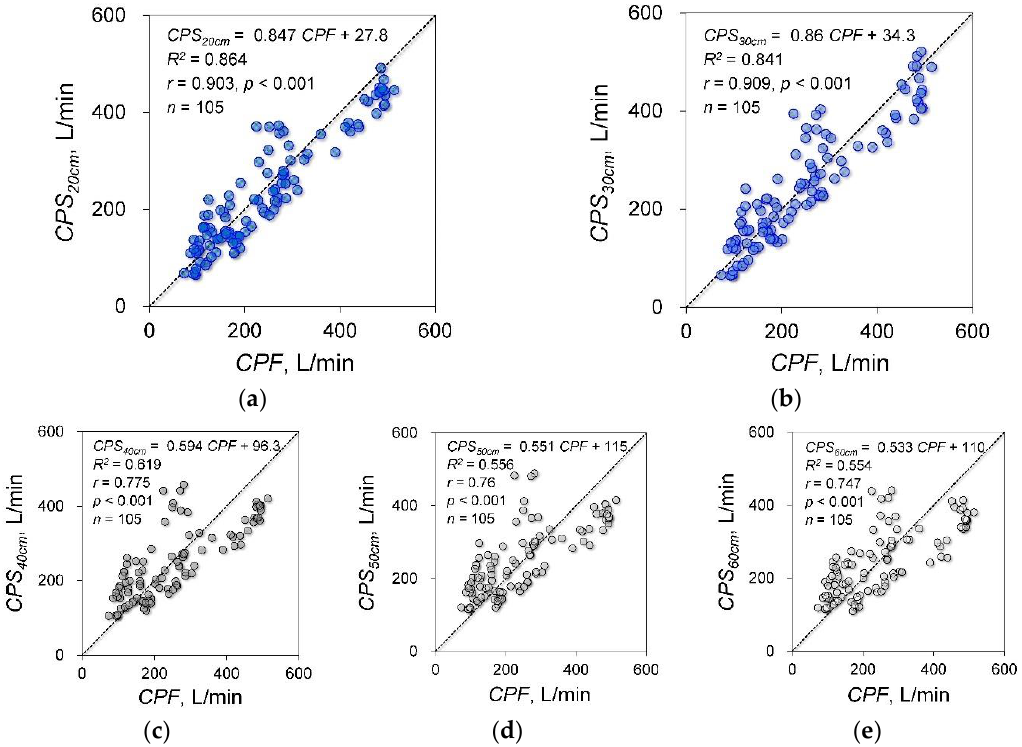
Figure 4. Estimation accuracy in each measurement condition. ( a – e ): Scatter plots of the measured data and the regression results of the proposed model: CPSL 20 cm –60 cm , cough peak sound pressure level measured by each microphone installed 20 cm, 30 cm, 40 cm, 50 cm and 60 cm from the point of face mask contact with the face; CPS 20 cm –60 cm , estimated cough peak flow calculated by CPSL 20 cm –60 cm . Solid lines represent regression lines derived from CPF and CPSL . The variation around the identity line is visibly reduced in graphs ( a , b ).